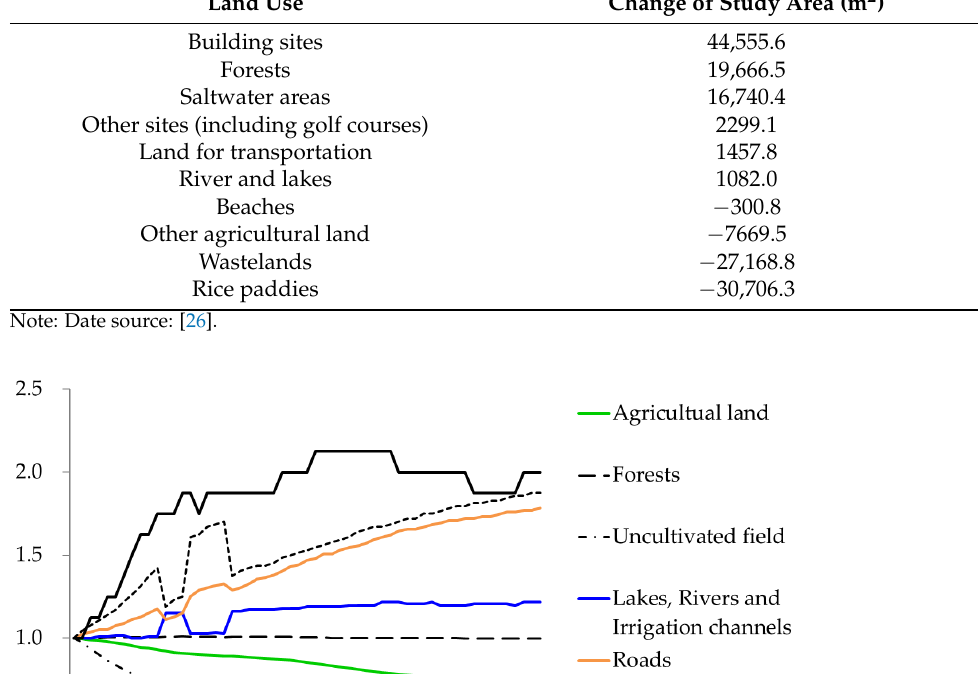
Figure 3. Proportion of casualties among the study areas and proportion of nationwide population, stratified according to agricultural area type. (Date sources: [14,25,28]).